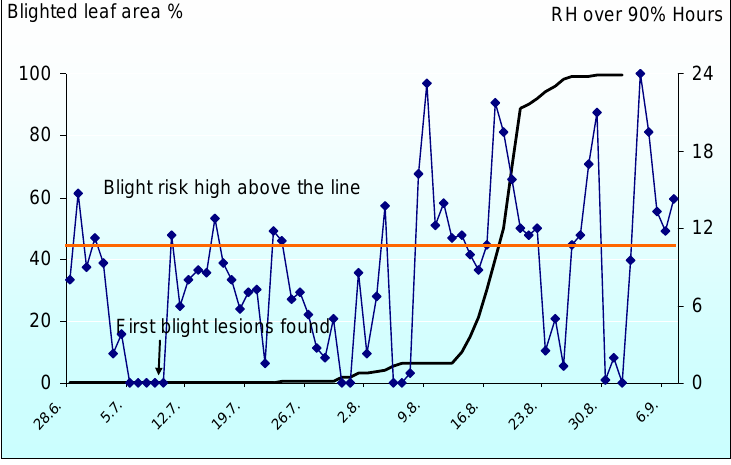
Figure 8 . Duration of periods (hours), when relative humidity was more than 90 % and temperature over 8 °C and progress of potato late blight epidemic (percentage of defoliated leaf area) at Jokioinen in non-protected susceptible potato cultivar in